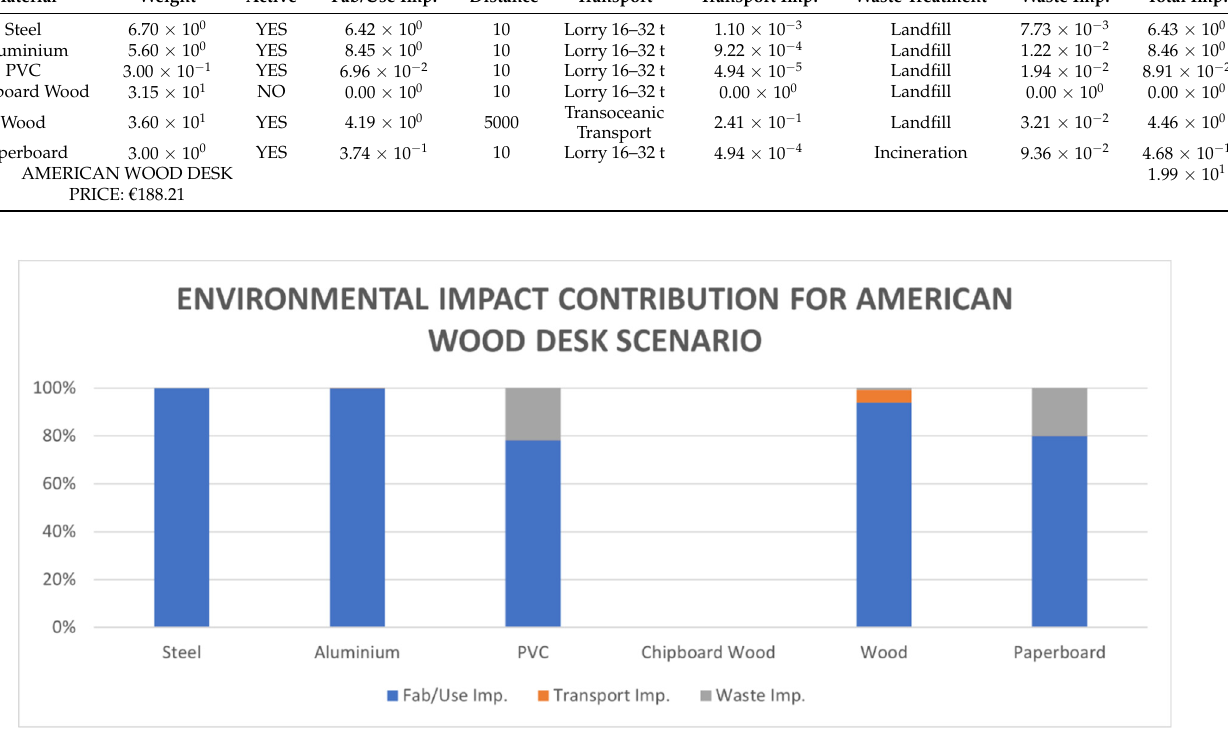
Figure 2. Environmental impact contribution for American wood desk scenario. If the option of using wood instead of chipboard is considered, though including a local supplier, along with the scenario of possible recycling this wood at the end of its useful life (see Table 10 and Figure 3), the results vary significantly. The environmental impact is thus reduced by 2.4 × 10 0 pt., as the total impact of the desk is 1.66 × 10 1 pt. Table 10. Results of wood desk + recycling scenario.